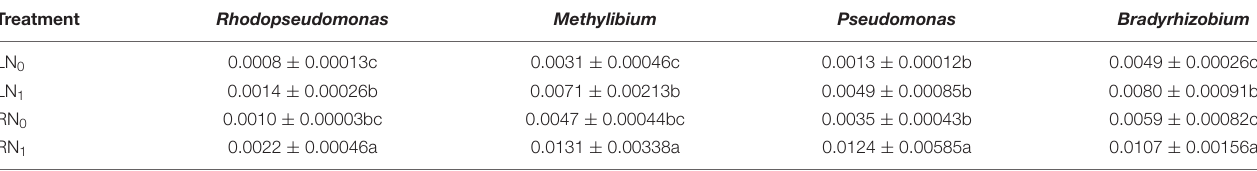
TABLE 2 | Effect of temperature and nitrogen application on significantly different carbon- and nitrogen-fixing bacterial genera in the rhizosphere soil.